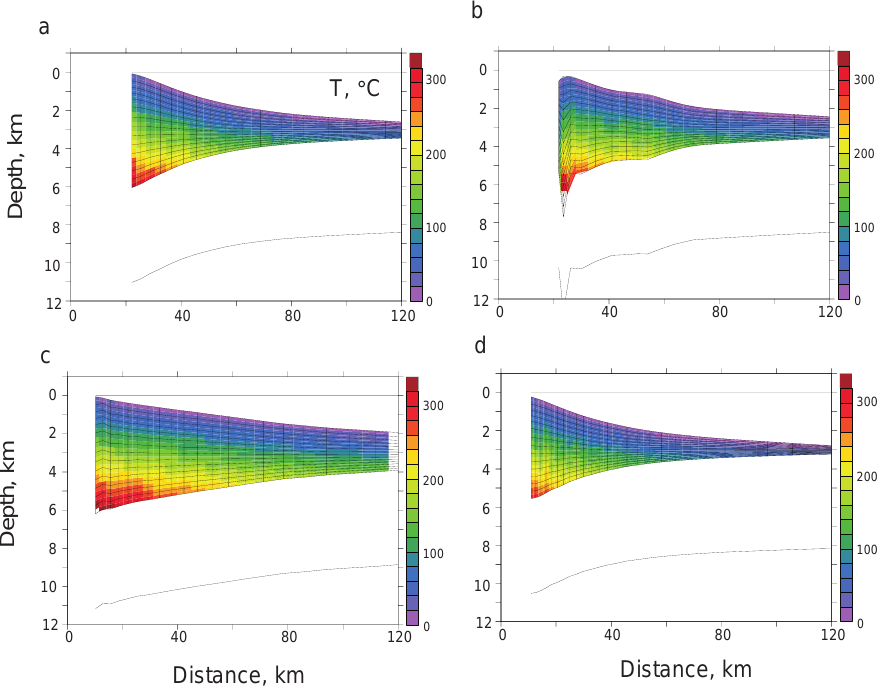
Fig. 2. Grid, temperature, and isostasy results for (a) Base , (b) Bumpy , (c) Broad Slope , and (d) Plate 80 . Results from other scenarios can be seen in the Supplement file temperature.pdf, and a movie of the Base scenario can be seen at http://geosci.uchicago.edu/ ∼ archer/ spongebob active/temperature.active.movie.gif.